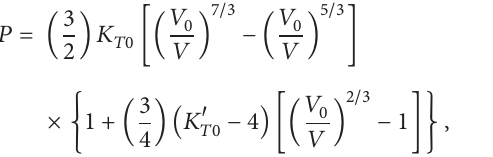
where 𝑉 0 , 𝑉 , 𝐾 𝑇0 , and 𝐾 󸀠 𝑇0 are the zero-pressure volume, high-pressure volume, isothermal bulk modulus, and its pres- sure derivative, respectively. The results from a least-squares fitting using an EosFit program [35] are 𝑉 0 = 1727.9(2) ˚A 3 , = 145(3) GPa, and 𝐾 󸀠 = 8.5(9) , respectively. When 𝐾 𝑇0 𝑇0 𝐾 󸀠 𝑇0 is set as 4, the isothermal bulk modulus is determined as 158(2) GPa. The unit-cell volume data as a function of pressure and the compression curve calculated from these fitted parameters are plotted in Figure 3. To assess the quality of the Birch-Murnaghan equation of state fit obtained from the plot of unit-cell volume against pressure, the relationship between the Eulerian strain ( 𝑓 𝐸 = 0.5[(𝑉 /𝑉) 2/3 − 1]) and the normalized pressure ( 𝐹 = 0 𝐸 (2𝑓 + 1) 5/2 ]) was plotted [35], and it is shown in 𝑃/[3𝑓 𝐸 𝐸 Figure 4. The 𝐹 𝐸 - 𝑓 𝐸 plot provides a visual indication of 󸀠 which higher order terms, such as 𝐾 𝑇0 , are significant in the equation of state. The Mg 3 Y 2 (SiO 4 ) 3 data showed a relatively large positive slope (Figure 4). This indicates that the pressure derivative of the bulk modulus ( 𝐾 󸀠 𝑇0 ) was larger than 4. Therefore, the value, estimated to be 8.5(9), was consistent with the 𝐹 𝐸 - 𝑓 𝐸 plot